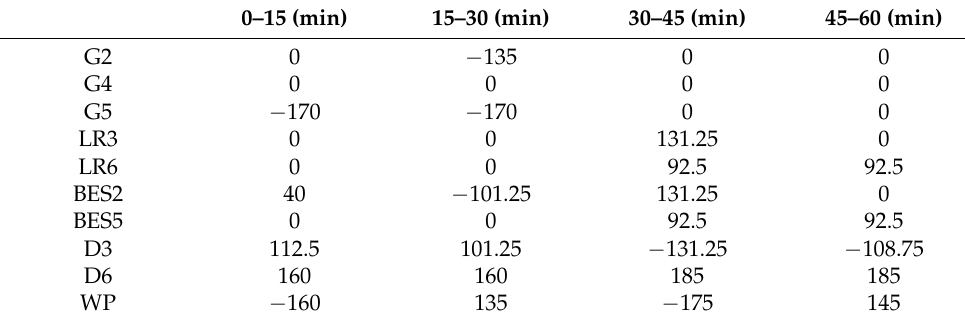
Table 5. Cost and payment of resources in the balancing market